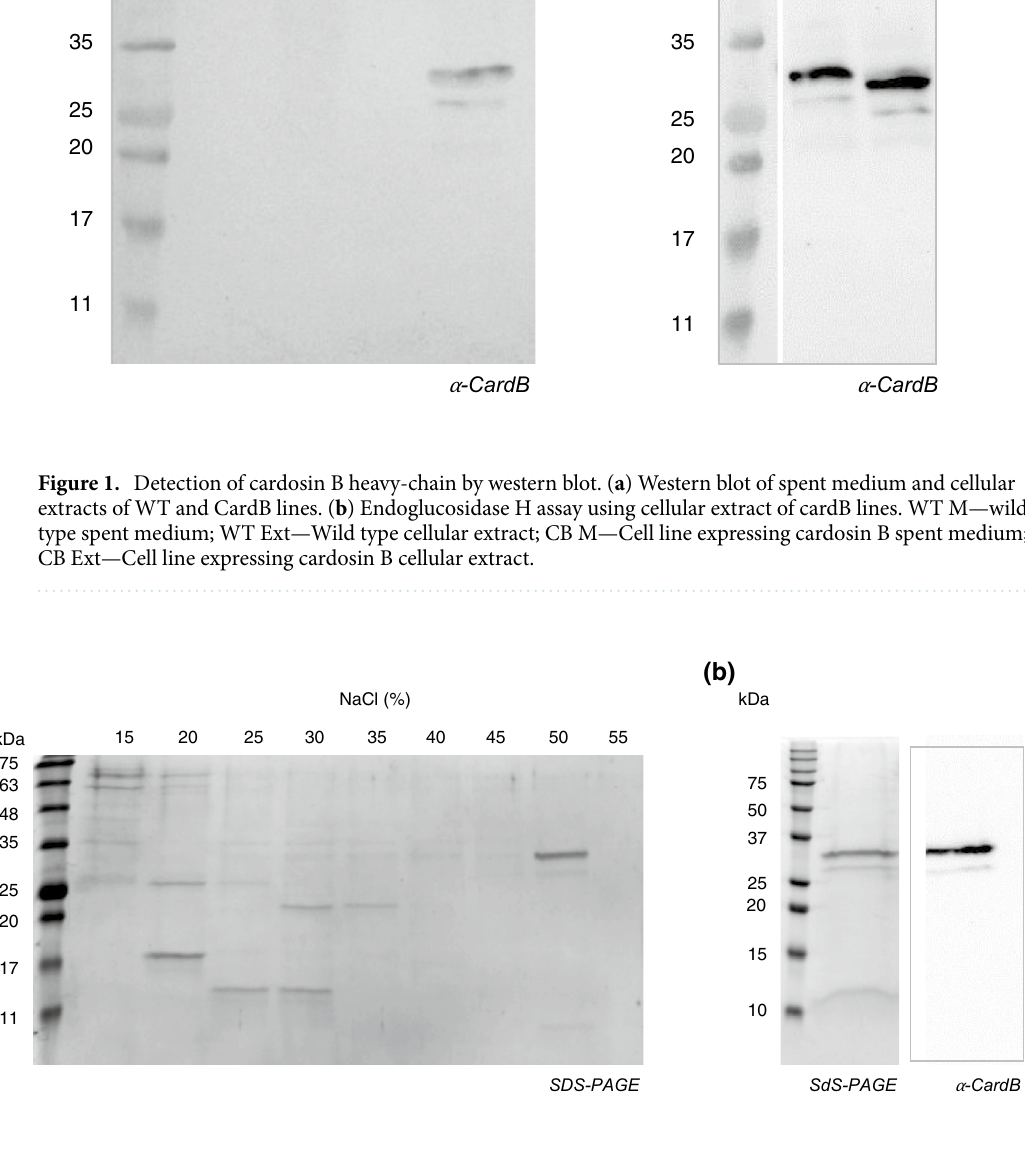
Figure 2. Purification of cardosin B by ion exchange chromatography. ( a ) SDS-PAGE analysis of NaCl gradient eluted fractions of cardosin B purification by Q-sepharose column. The molecular weight ladder was NZYColour Marker II (NZYTech) ( b ) SDS-PAGE and western blot analysis of purified cardosin B. The molecular weight ladder used was Precision Plus Protein WesternC Standards